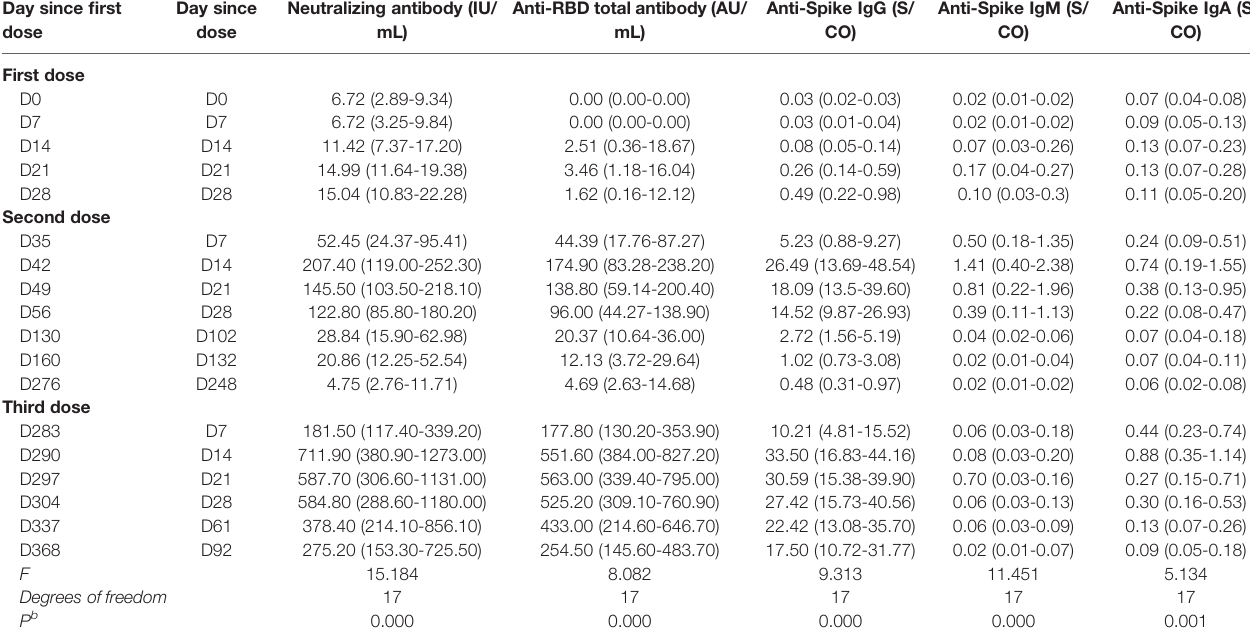
TABLE 3 | Anti-SARS-CoV-2 antibodies levels over time after vaccination a . Day since fi rst dose